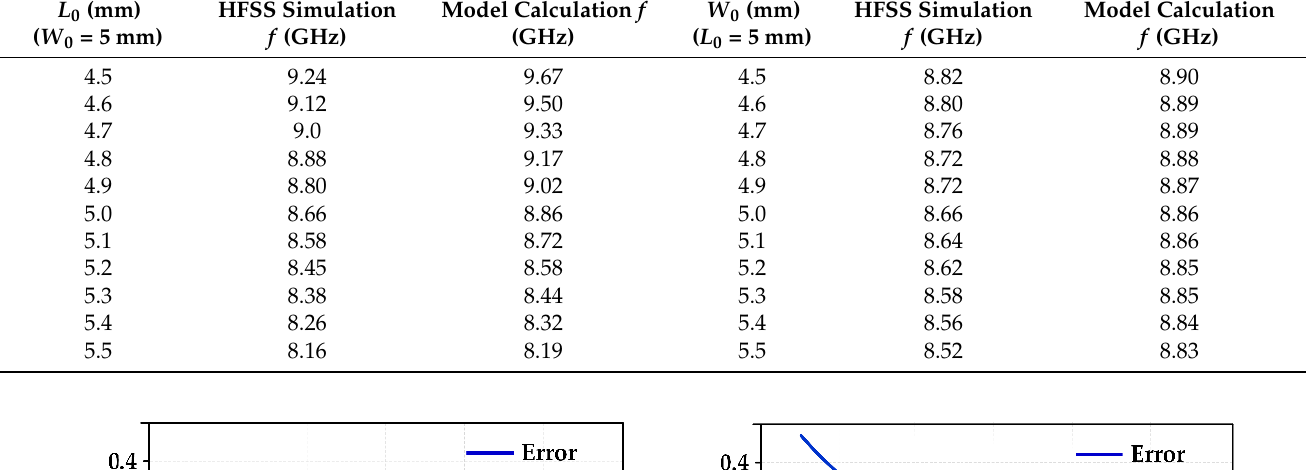
Table 7. HFSS simulation results and coupling model calculation results of different W 0 and L 0 pa- rameters under Mode 2 antenna.